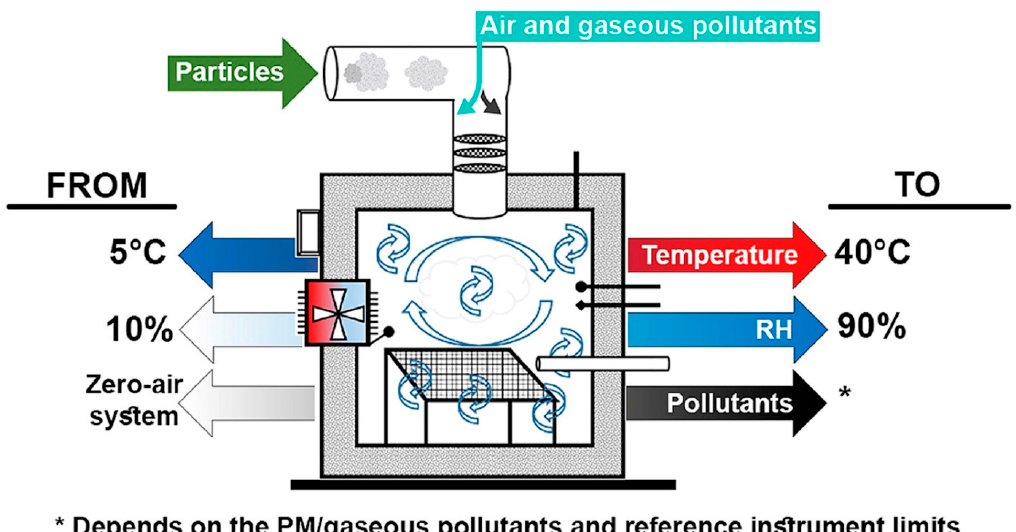
Figure 13. Schematic of the chamber system with the main components developed by